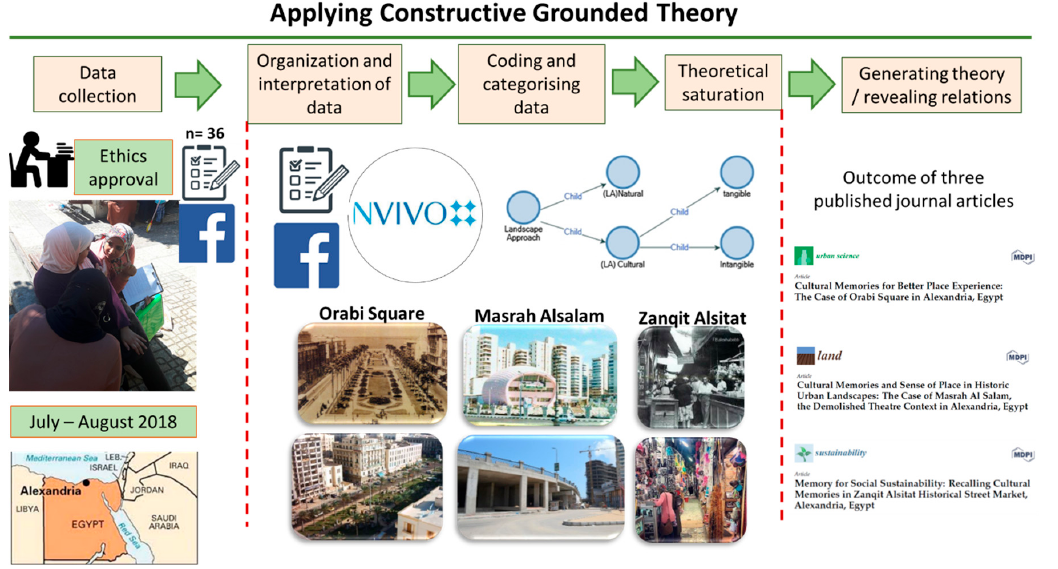
Figure 1. Diagram showing the stages of applying constructivist GT for this research. Source: F. Hussein.